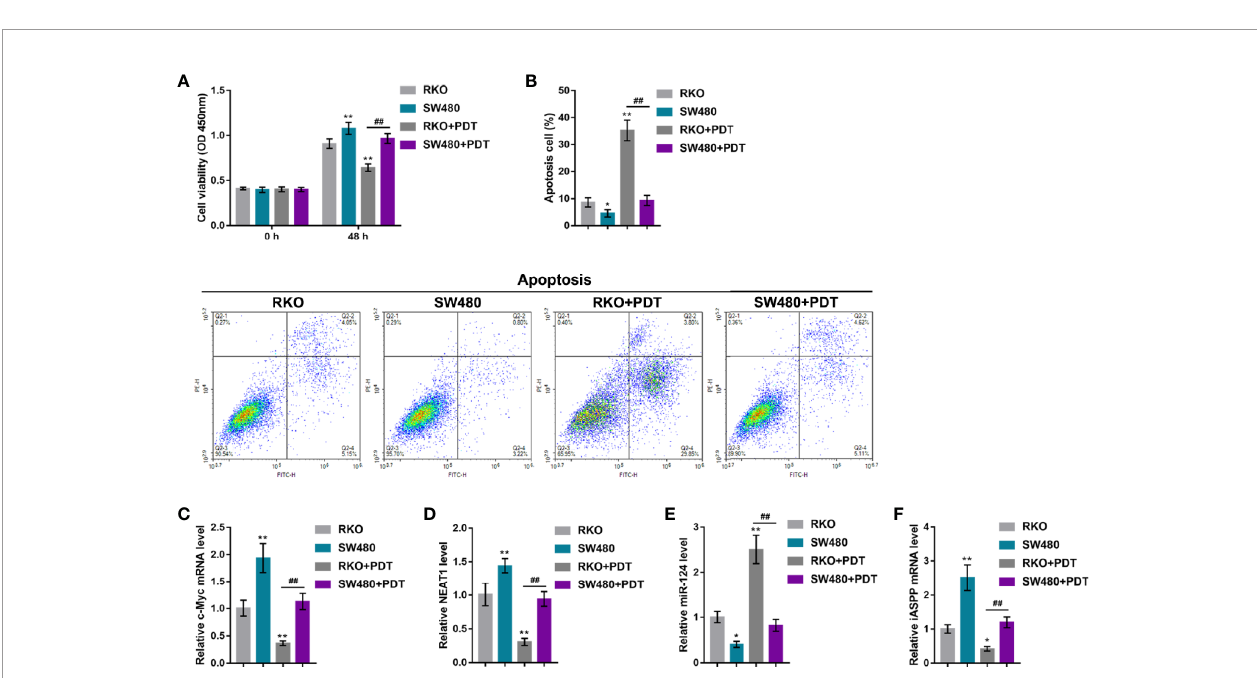
FIGURE 7 | p53 mutation enhances the resistance of CRC cells to PDT. p53 wt RKO and p53 mut SW480 cells were treated or non-treated with PDT and examined for cell viability by CCK-8 assay (A) , cell apoptosis by Flow cytometry (B) , and the expression levels of c-Myc (C) , NEAT1 (D) , miR-124 (E) , and iASPP (F) by qRT-PCR. * P < 0.05, ** P < 0.01, compared to RKO cells. ## P < 0.01 compared to RKO+PDT